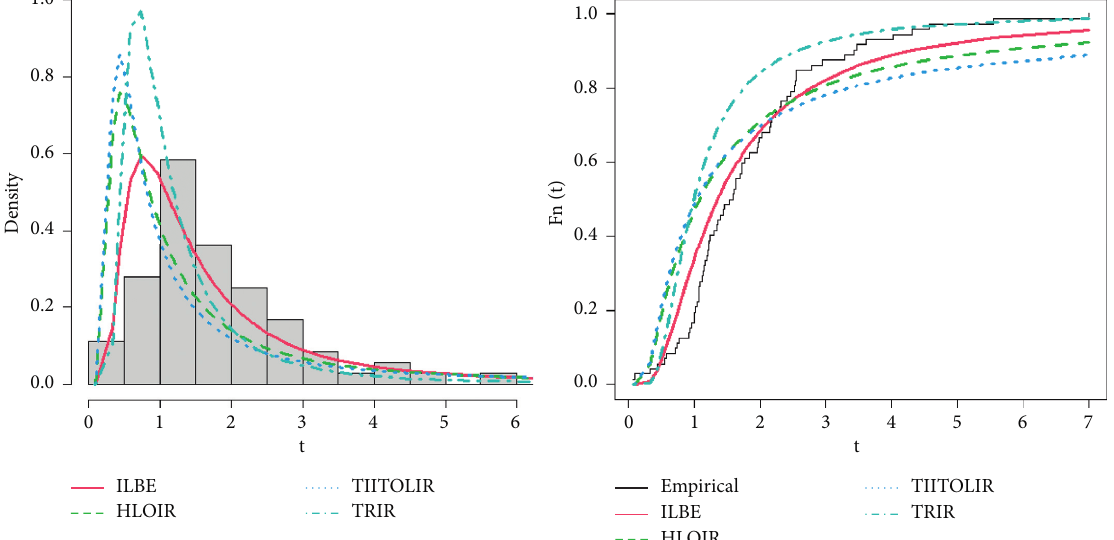
Figure 2: Fitted PDFs and CDFs of comparison models for the first dataset.